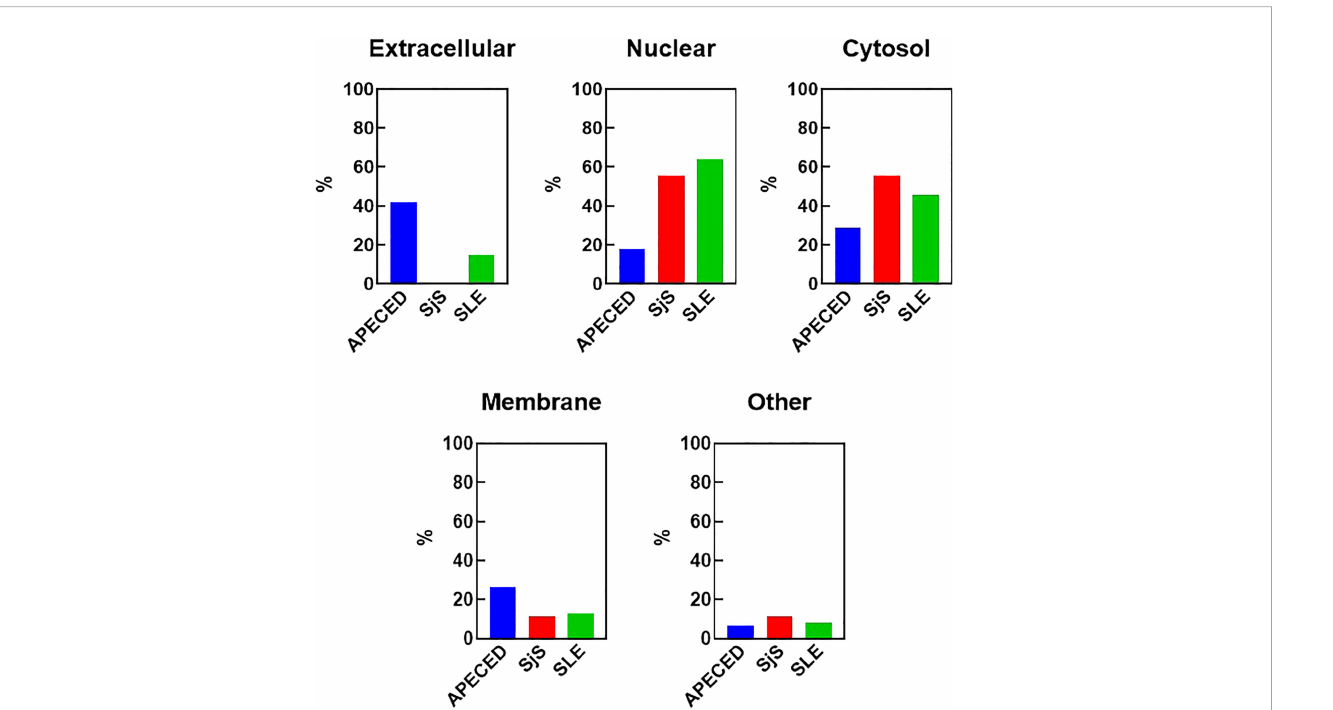
FIGURE 4 Cellular localization of the reactivities de fi ning the different disease groups. The reactivities changed with a Z-score greater than 5 in at least 30% of the patients for each group were considered to be representative for each disease group. The cellular localization of the different antigens was determined using GO terms and also by manual curation for unde fi ned genes. The percent of the group de fi ning reactivities assigned to each cellular location are graphed. Some antigens have an unknown localization and were classi fi ed as “ other ” . An antigen may have more than one localization. APECED, autoimmune polyendocrinopathy – candidiasis – ecto-dermal dystrophy; SLE, systemic lupus erythematosus; SjS, Sjogren ’ s syndrome; GO, gene